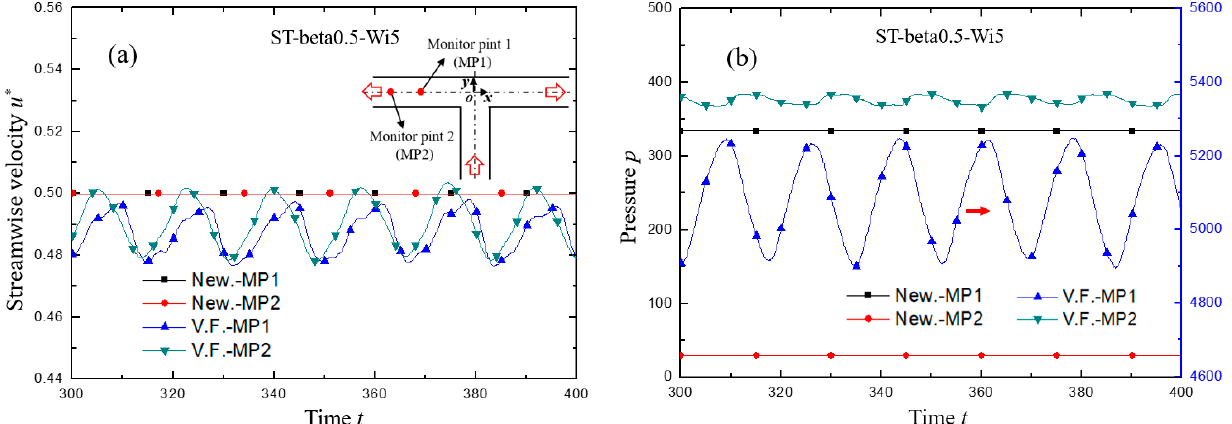
Figure 4. The variation of ( a ) streamwise velocity and ( b ) pressure with dimensionless time. In the legend, the symbols of MP1 and MP2 describe the monitor points of ( x , y ) = ( − 5, 0) and ( x , y ) = ( − 10, 0), respectively. The symbols of New. and V.F. denote respectively Newtonian and viscoelastic fluid. For both cases, Re = 0.01. For viscoelastic fluid, Wi = 5, β = 0.5.